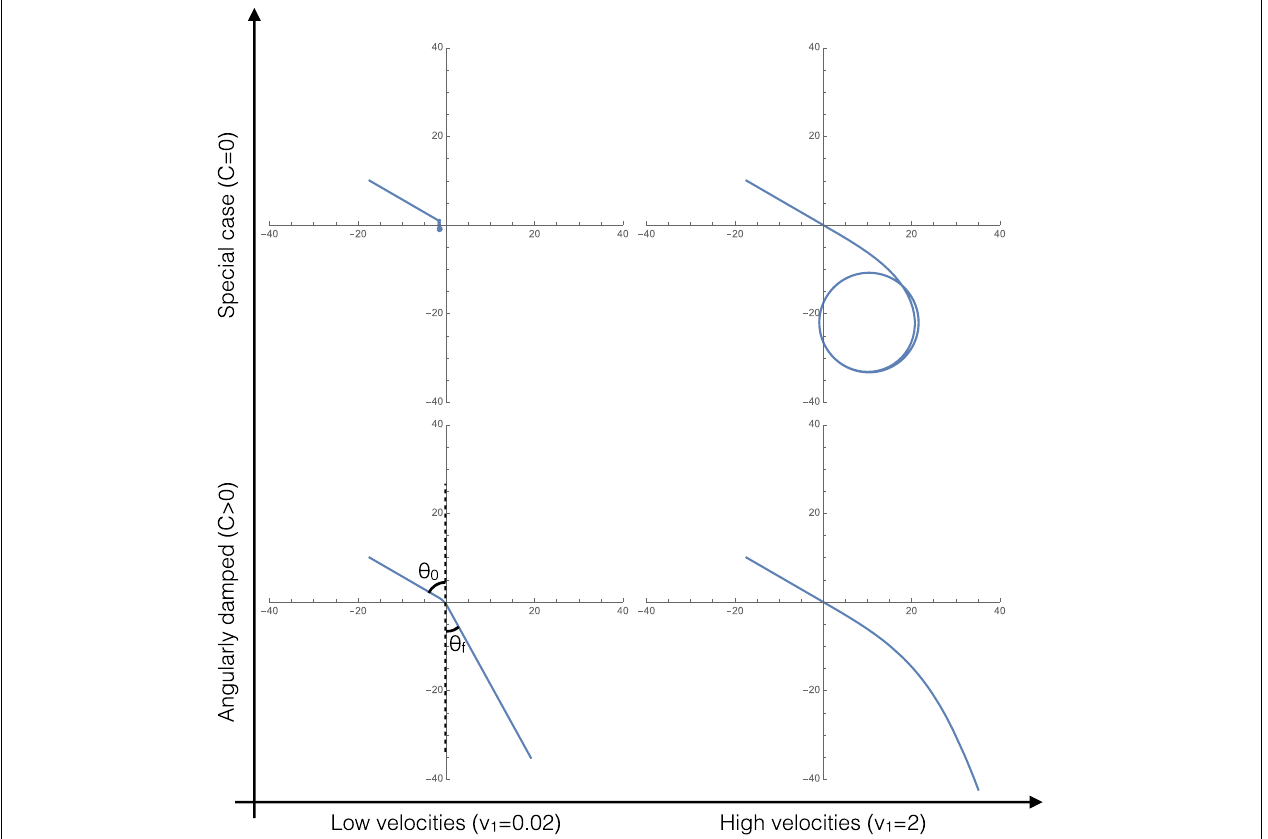
FIGURE 2 | Representative trajectories of the system in each of the four limiting behaviors of the system . In all four cases, v 1 = 2 v 2 .